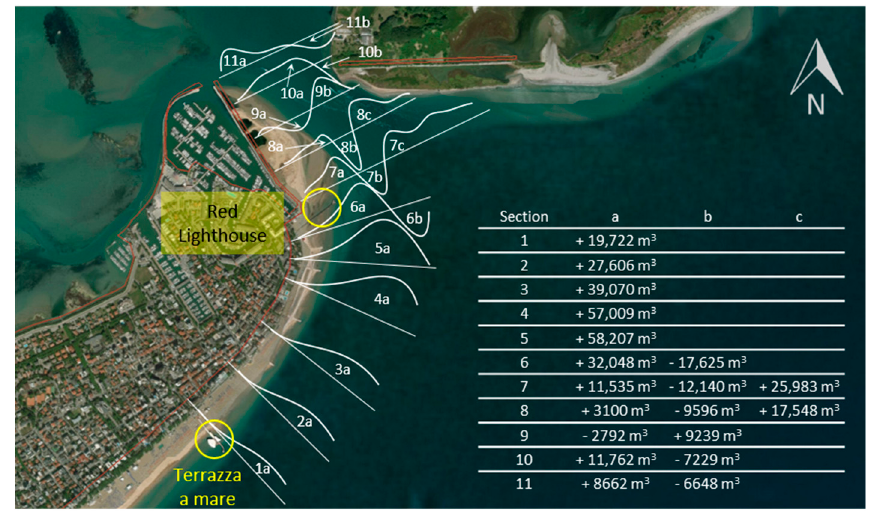
Figure 14. Net volumes of sediments crossing the sections on an average year. The positive volumes move from the outside towards the inside of the lagoon and vice versa.